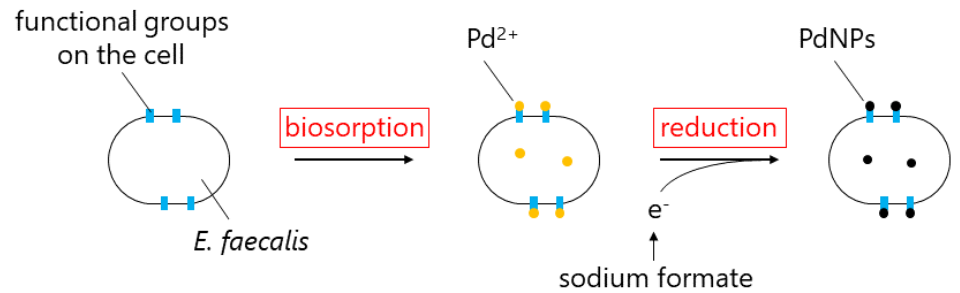
Figure 9. The mechanism of Pd NPs synthesis by E. faecalis . At first, the Pd ion was adsorbed on the cell and uptake into the cell. Carboxyl groups, hydroxyl groups, and amine groups were participated in adsorption. Next, the Pd ion was reduced. The ion donor was sodium formate.